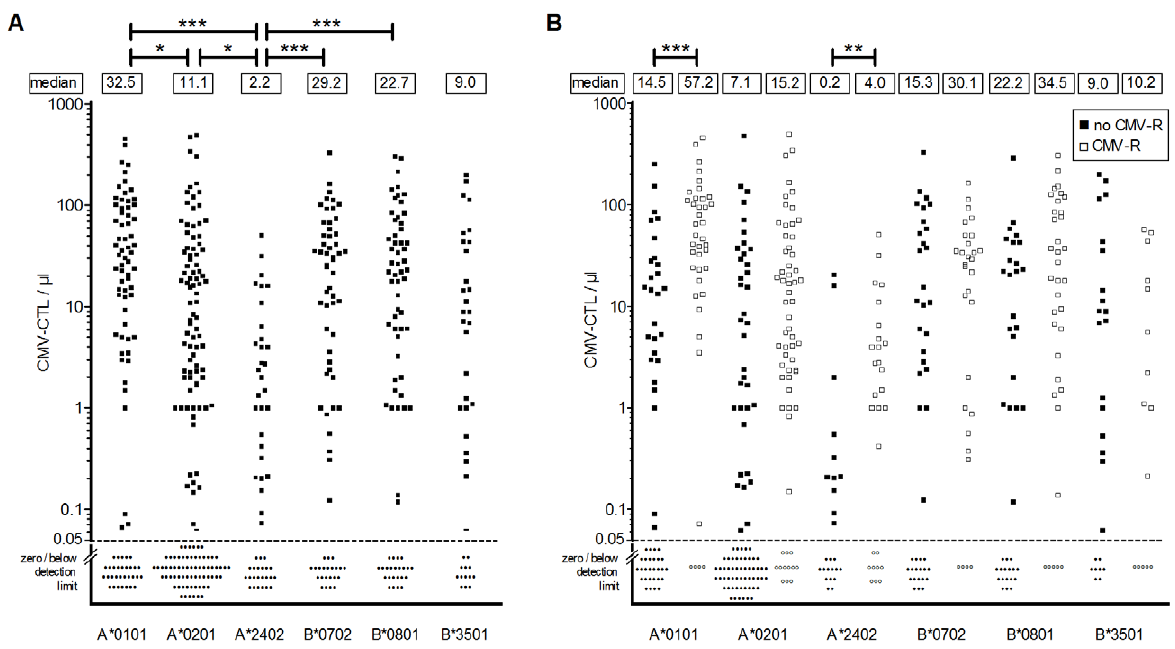
Figure 2. CMV-CTL levels vary depending on the HLA-epitope tetramer used for detection and the occurrence of CMV-reactivation. ( A ) Median circulating CMV-CTL levels in our patient cohort are shown for six different HLA-restricted CMV epitopes monitored by commercially available HLA-epitope tetramers. Data are shown for all patients with a detectable CD3 + /CD8 + T cell response (CMV-CTLs . 0 per m l blood) during the first year following HSCT, and summarized as mean values of CMV-CTLs calculated for each patient (filled squares). P-values were calculated using the Kruskal-Wallis test followed by Dunn’s multiple comparison. Patients not mounting a response (0 CMV-CTL per m l blood) or with cell counts below the detection limit are denoted below the dashed line. ( B ) Median CMV-CTL levels for each HLA-restricted CMV epitope are shown for each patient who experienced (empty squares, CMV-R) or did not experience (filled squares, no CMV-R) CMV reactivations. The median CMV-CTL levels from the entire cohort are shown in the box above each group. No results are shown for the HLA-A*1101 tetramer, since only one patient was monitored. * p # 0.05, ** p # 0.01, *** p # 0.001.